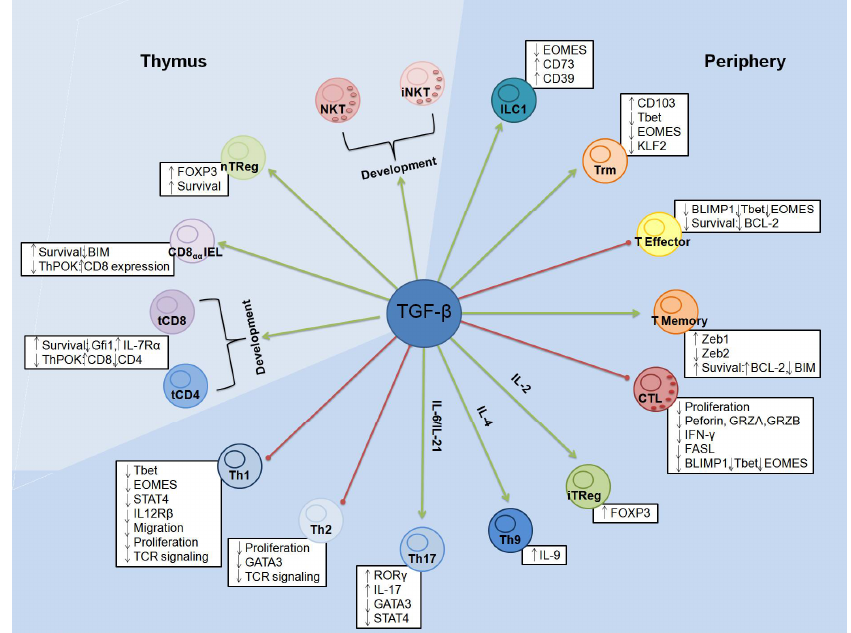
Figure 1. Overview of TGF-β effects on T-cell subsets. Graphical representation of positive (green) or inhibitory (red) effects of TGF-β signaling on T-cell differentiation across developing T cells (in the thymus, light blue) or mature T-cell subsets (in the periphery, dark blue). Mechanistic or physiologic impact of TGF- β signaling on the various T-cell subsets indicated in the white